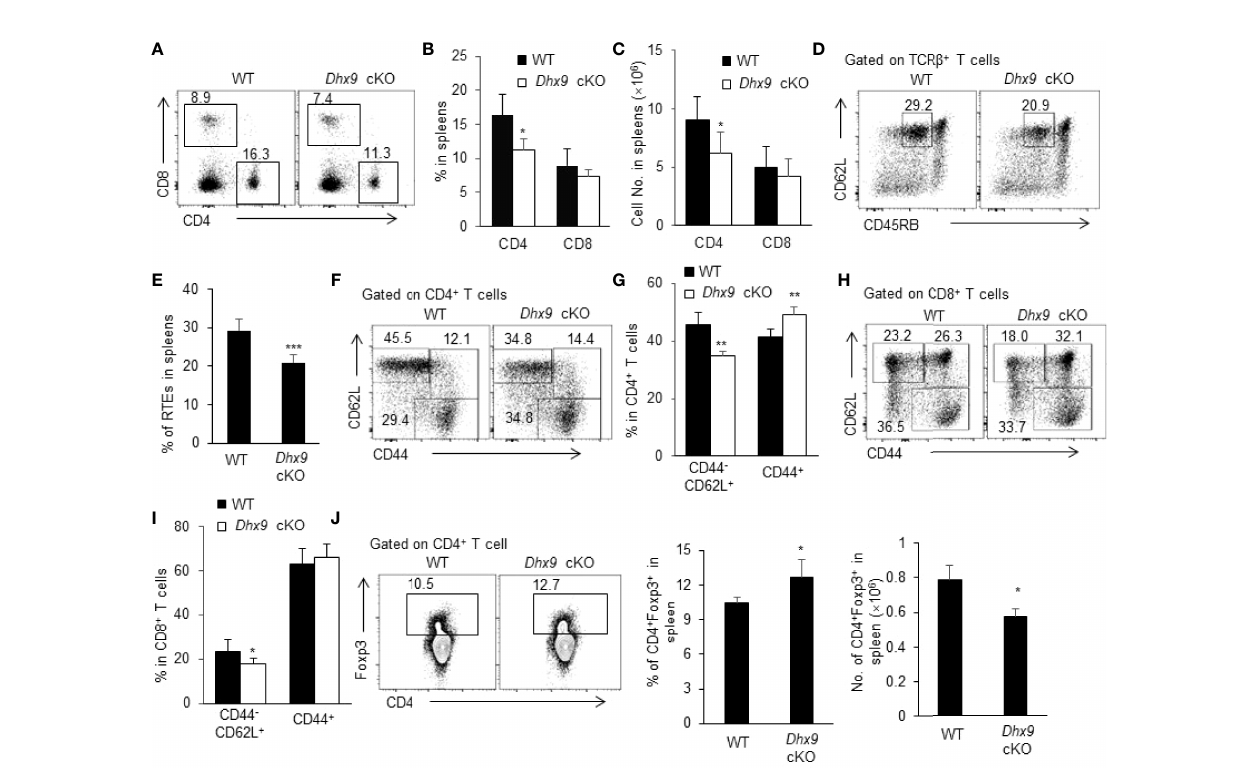
FIGURE 4 | The homeostasis of periphery T cells was broken in Dhx9 cKO mice. (A – C) The representative fl ow cytometry plots (A) , frequencies (B) , and numbers (C) of CD4 + T cell and CD8 + T cell from 4-week-old WT and Dhx9 cKO mice. (D, E) The representative fl ow cytometry plots (D) and frequencies (E) of CD3 + CD4 + CD62L + CD45RB int RTEs from 4-week-old WT and Dhx9 cKO mice. (F, G) The representative fl ow cytometry plots (F) and frequencies (G) of CD62L + CD44 - naïve and CD44 + activated T cells in CD4 + T cells in 4-week-old WT and Dhx9 cKO mice. (H, I) The representative fl ow cytometry plots (H) and frequencies (I) of CD62L + CD44 - naïve and CD44 + activated T cells in CD8 + T cells in 4-week-old WT and Dhx9 cKO mice. (J) The representative fl ow cytometry plots, frequencies, and numbers of Treg cells in the spleen of indicated genotype mice. One representative histogram represented the mean ± SD for n = 5 mice in each group. The unpaired, two-tailed student ’ s t -test was used. * P < 0.05, ** P < 0.01, *** P < 0.001 compared with WT control